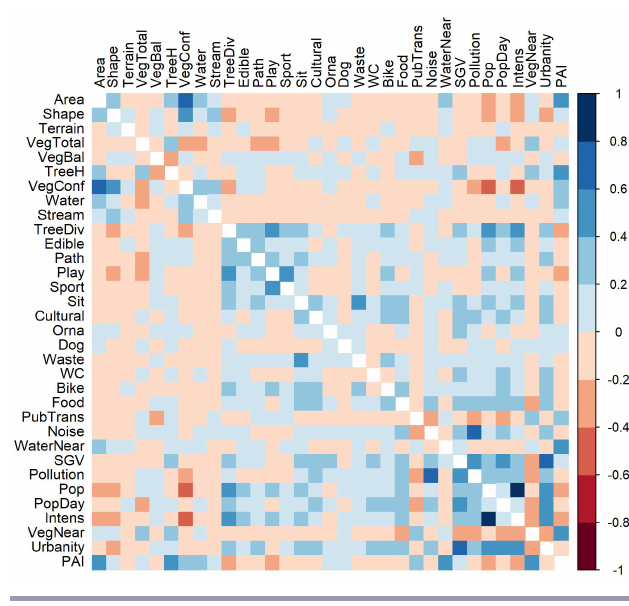
Fig. 4 . Correlation matrix for the 33 park-quality indicators with red shades for negative and blue shades for positive Pearson coefficients.